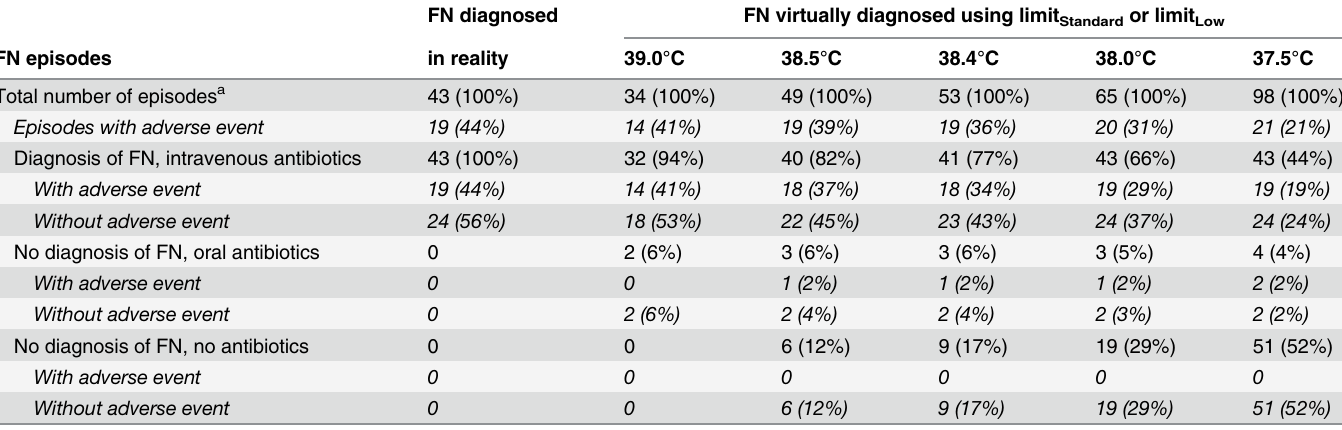
Table 3. Clinical Course of FN Episodes Diagnosed in Reality, and Virtually at Different Temperature Limits De fi ning Fever. FN diagnosed FN virtually diagnosed using limit Standard or limit